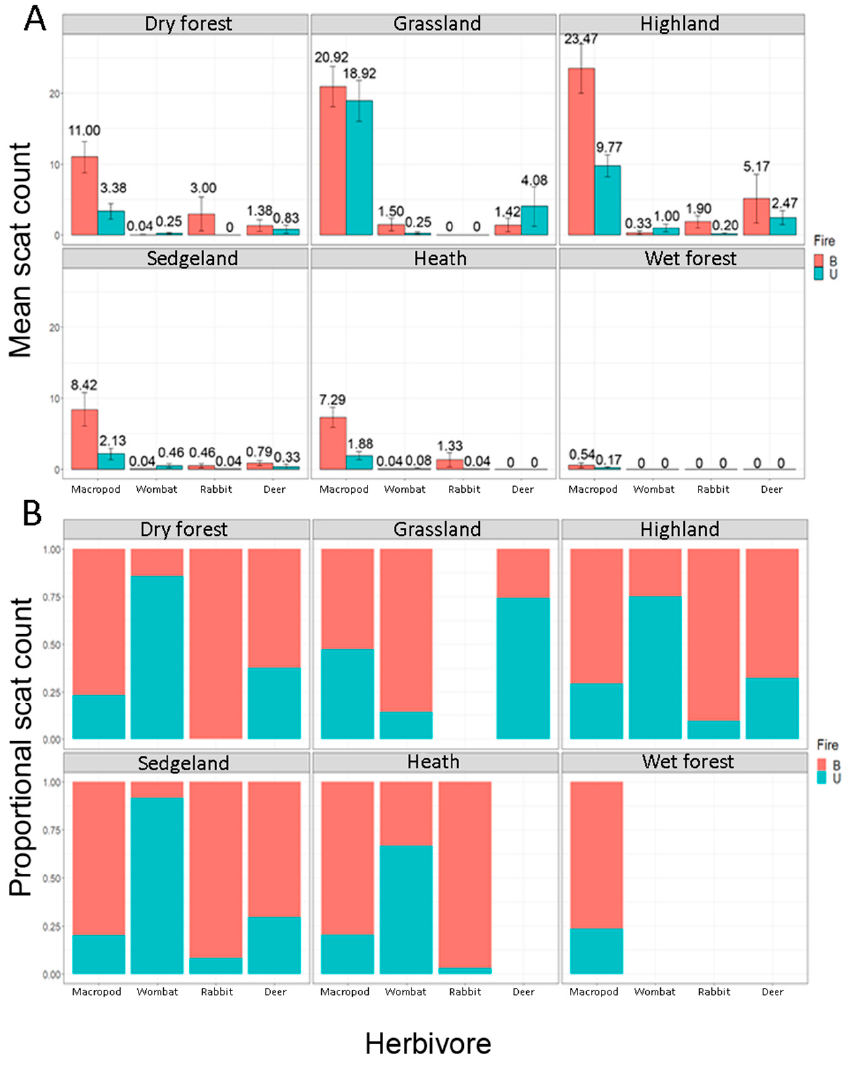
Figure 5. (( A )-top) Mean scat count with standard error bars for recently burned (B, red) and unburned (U, blue) sites, by vegetation community type and (( B) -bottom) scat count presented as a proportion of abundance within recently burned (red) and unburned (blue) environments. Dry forest, Grassland, Highland, Sedgeland, Heath, and Wet Forest. Table 2. Results of two-way nested hierarchical analysis of variance (ANOVA) for each of four species (native species indicated by *) in Tasmania assessing the impact of fire nested within vegetation communities. Greyed results are not